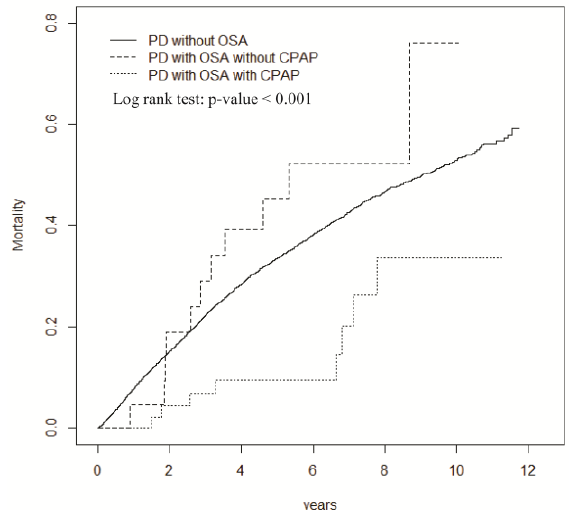
Figure 3. Cumulative incidence of mortality for PD patients with and without OSA, and OSA patients receiving continuous positive airway pressure (CPAP) treatment.